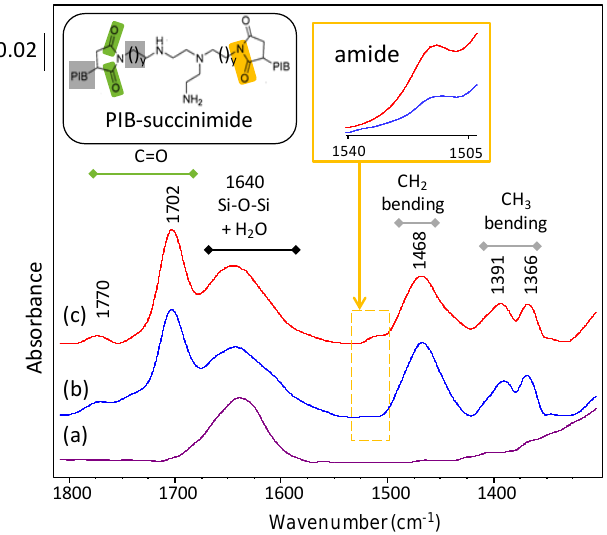
Figure 7. FTIR spectra of ( a ) fresh LTL and LTL extracted after 24 h of heating at 150 °C from ( b ) SA-C3, and ( c ) SA-C2 lubricant samples. Inset, one possible structure of PIB-succinimide.